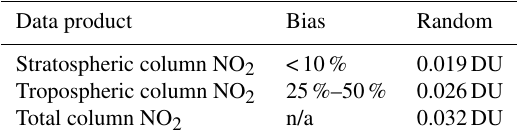
Table 1. TROPOMI NO 2 data product requirements extracted from the S5P Calibration and Validation Plan (ESA EOP-GMQ,